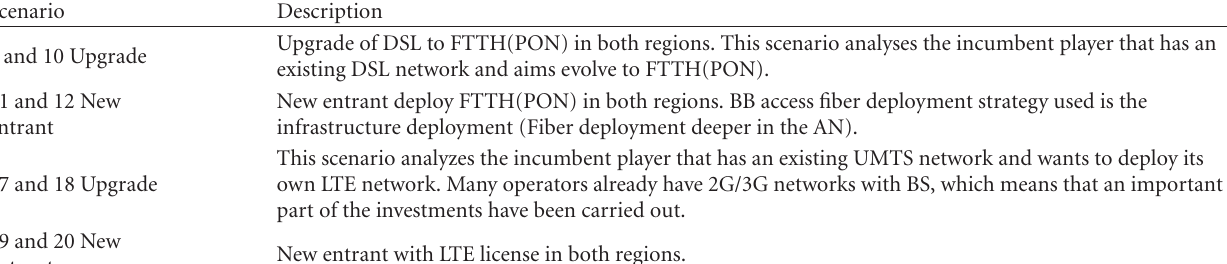
Table 12: General economic results: FTTH(PON).